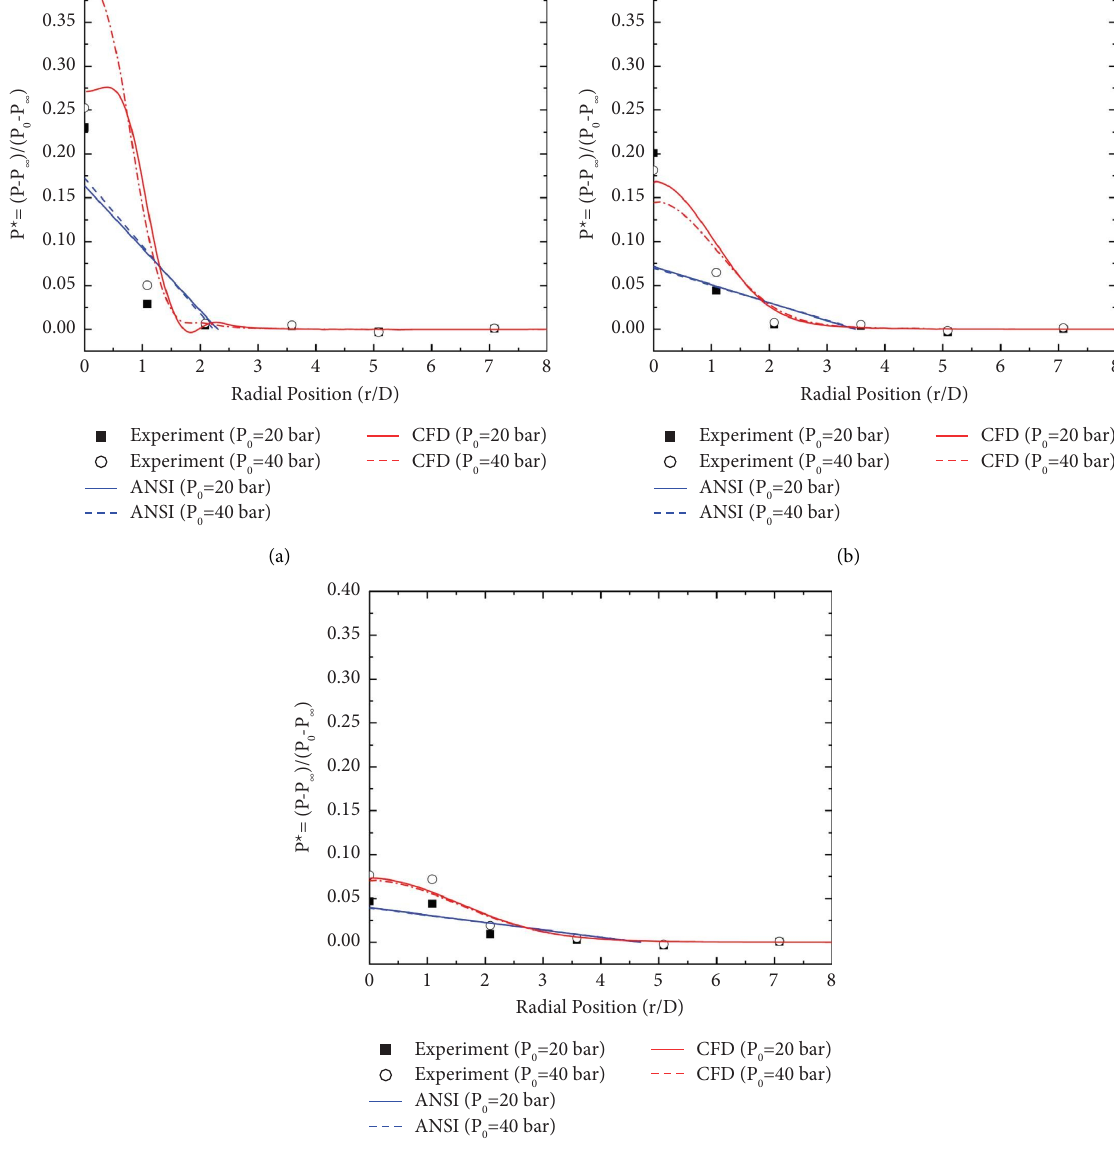
� (a) 500mm (6.78 D), (b) 1000mm (13.57D), and (c) 1500mm target